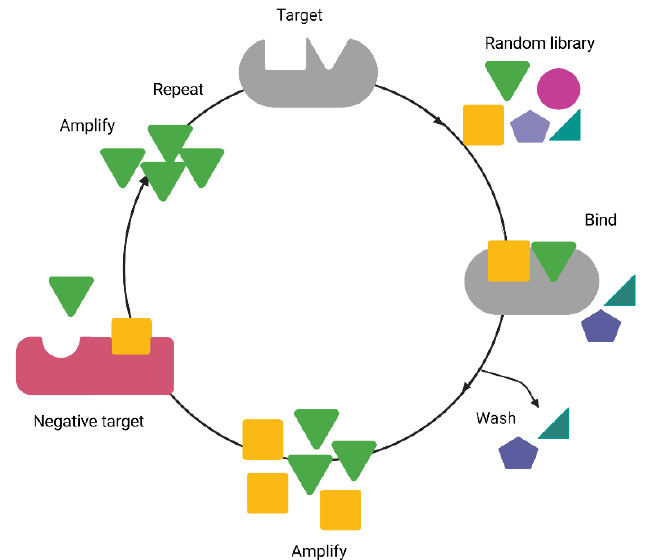
Figure 1. An illustration of the basic schematic of the Systematic Evolution of Ligands by Exponential Enrichment (SELEX) process. The random library of oligonucleotides is subjected to alternate incubation cycles with the target of interest and counter (negative) targets. The process is typically repeated up to 15 times to increase the binding affinity and specificity of the oligonucleotide library. The final enriched library may contain one or more candidate aptamers. The figure was created with BioRender.com.